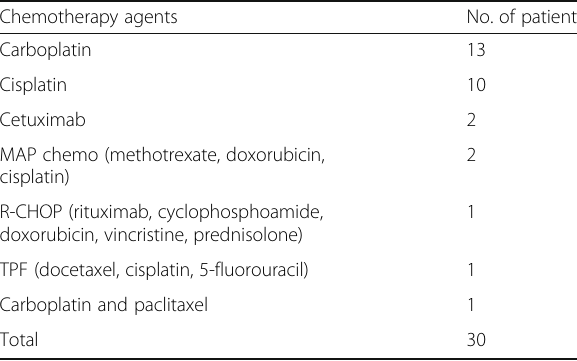
Table 6 Chemotherapy agents used within the study population Chemotherapy